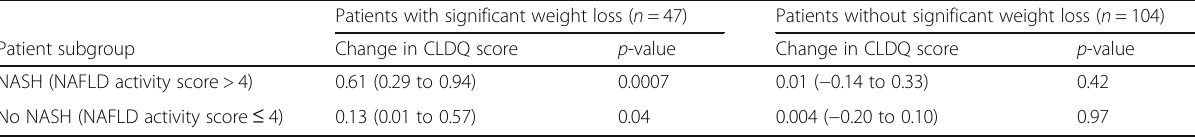
Table 5 Changes in CLDQ score by NASH status in patients with and without significant weight loss (Tapper and Lai, 2016) [14] Patients with significant weight loss ( n =